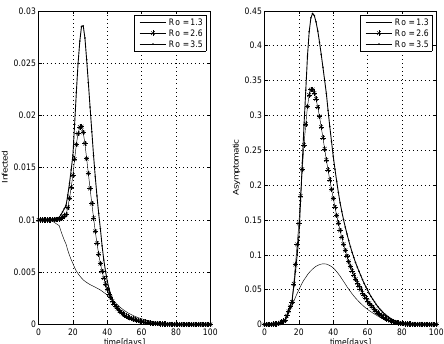
Fig. 1: Infectious and asymptomatic